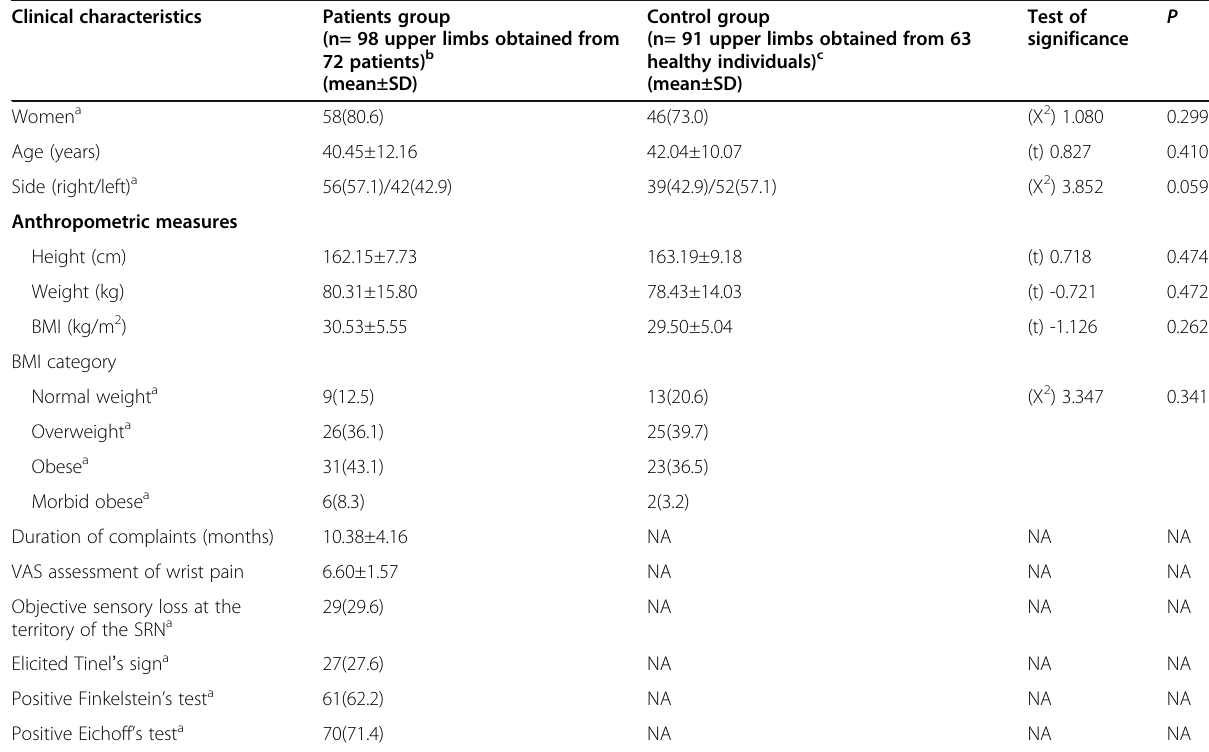
Table 2 Clinical characteristics of the patients and control groups Clinical characteristics Patients group